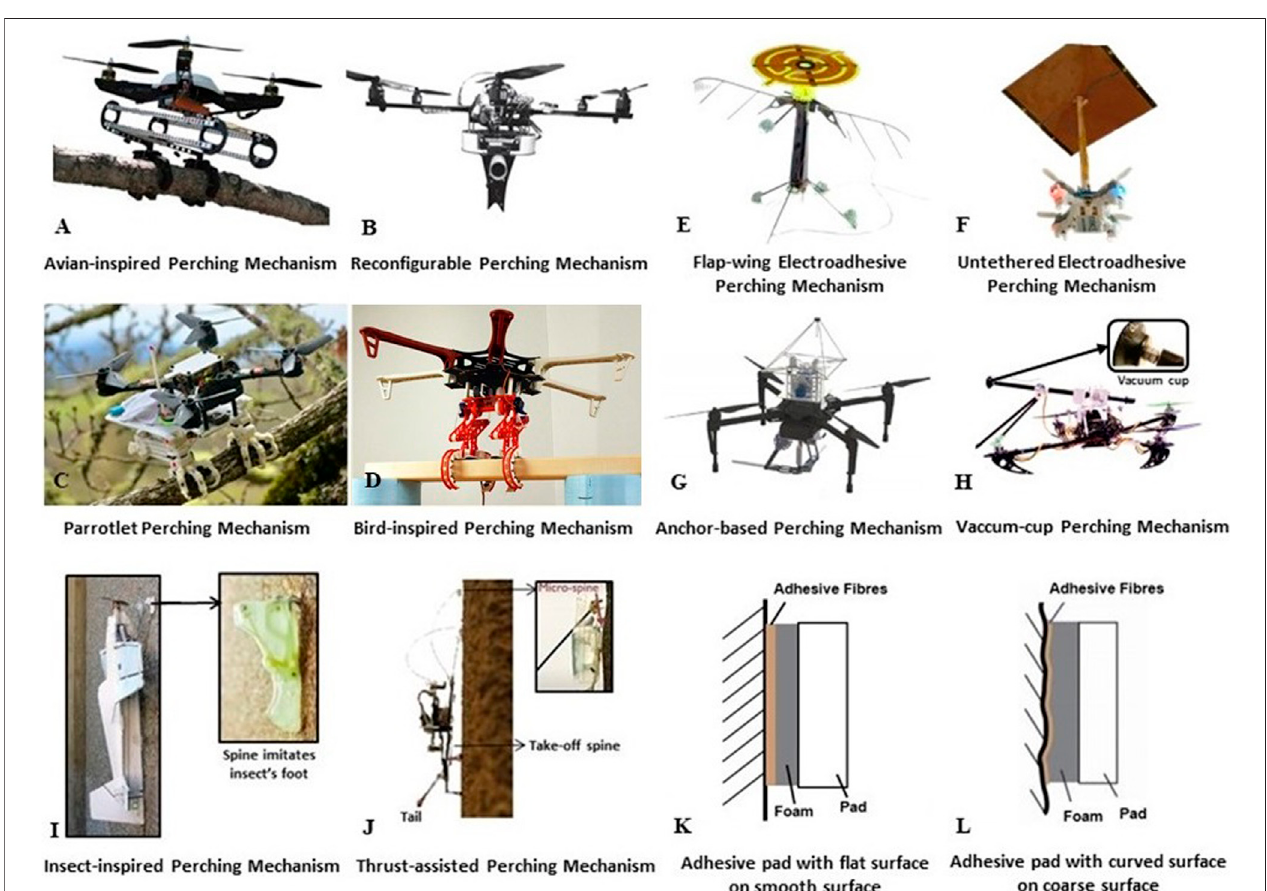
FIGURE 7 | Sub fi gures (A) to (D) demonstrate aerial manipulators with grasping mechanisms for aerial perching: (A) is an Avian-inspired Perching Mechanism developed by University of Utah Robotic Systems Lab (Doyle et al., 2012) which is presented in Section. 3.1.1 , (B) is a Recon fi gurable Perching Mechanism developed by University of Southampton Autonomous Systems Lab (Erbil et al., 2013) which is presented in Section 3.1.2 , (C) is a Parrotlet Perching Mechanism developed by Standford University Biomimetics and Dextrous Manipulation Lab (Roderick et al., 2021) which is presented in Section 3.1.6 and (D) is a Bird-inspired Perching Mechanism developed by Olin College of Engineering (Nadan et al., 2019) which is presented in Section. 3.1.5 ; (E) to (H) demonstrate aerial robots and aerial manipulators with attaching mechanisms for aerial perching: (E) is a Flap-wing Electroadhesive Perching Mechanism developed by MIT, Harvard University,